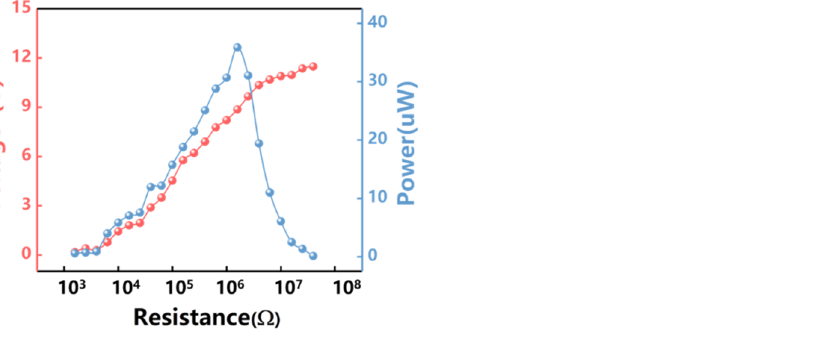
Figure A3. Output voltage and peak power of RWTP versus the resistance of external load.